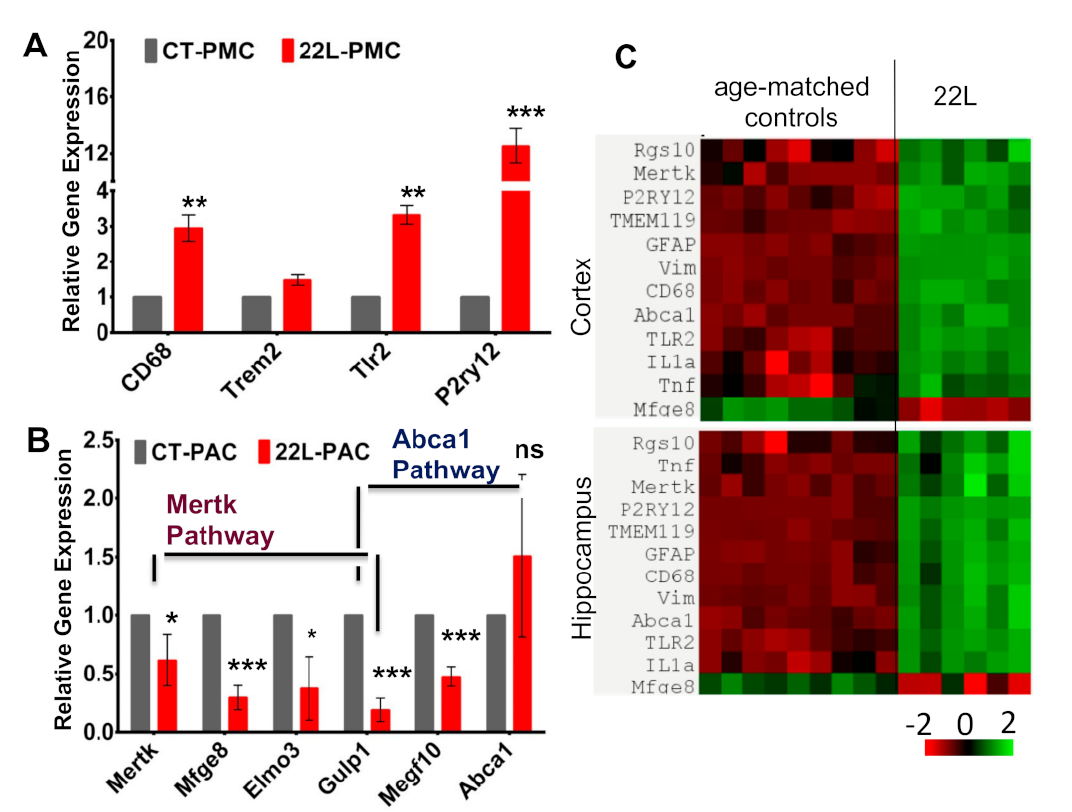
Figure 8. Analysis of gene expression. ( A , B ) Expression of genes associated with phagocytosis in 22L-PMCs normalized by the expression levels in CT-PMCs ( A ), or 22L-PACs normalized by the expression levels in CT-PACs ( B ) analyzed by qRT-PCR. Gapdh was used as the housekeeping gene. Data represent mean ± SEM, n = 3 independent cultures isolated from individual animals, each analyzed in triplicates, * p ≤ 0.05, ** p ≤ 0.01, *** p ≤ 0.001, and ‘ns’ non-significant by a two-tailed, unpaired student t-test. ( C ) Heat map of gene expression in cortex and hippocampus of 22L-infected and age-matched control mice ( n = 6 animals per